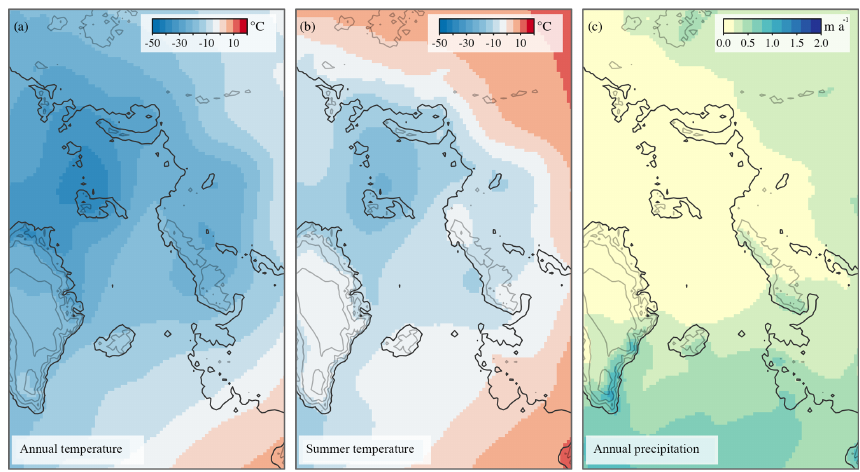
Figure 1. Background climatic forcing for the control run (CTRL). MIS 3 ( ∼ 40kyrBP) reference annual mean SAT (a) and summer mean SAT (b) in degrees Celsius and annual mean precipitation in meters per annum (c) . Present-day contour lines with the land boundary delineated at a depth of − 80m are added for reference.